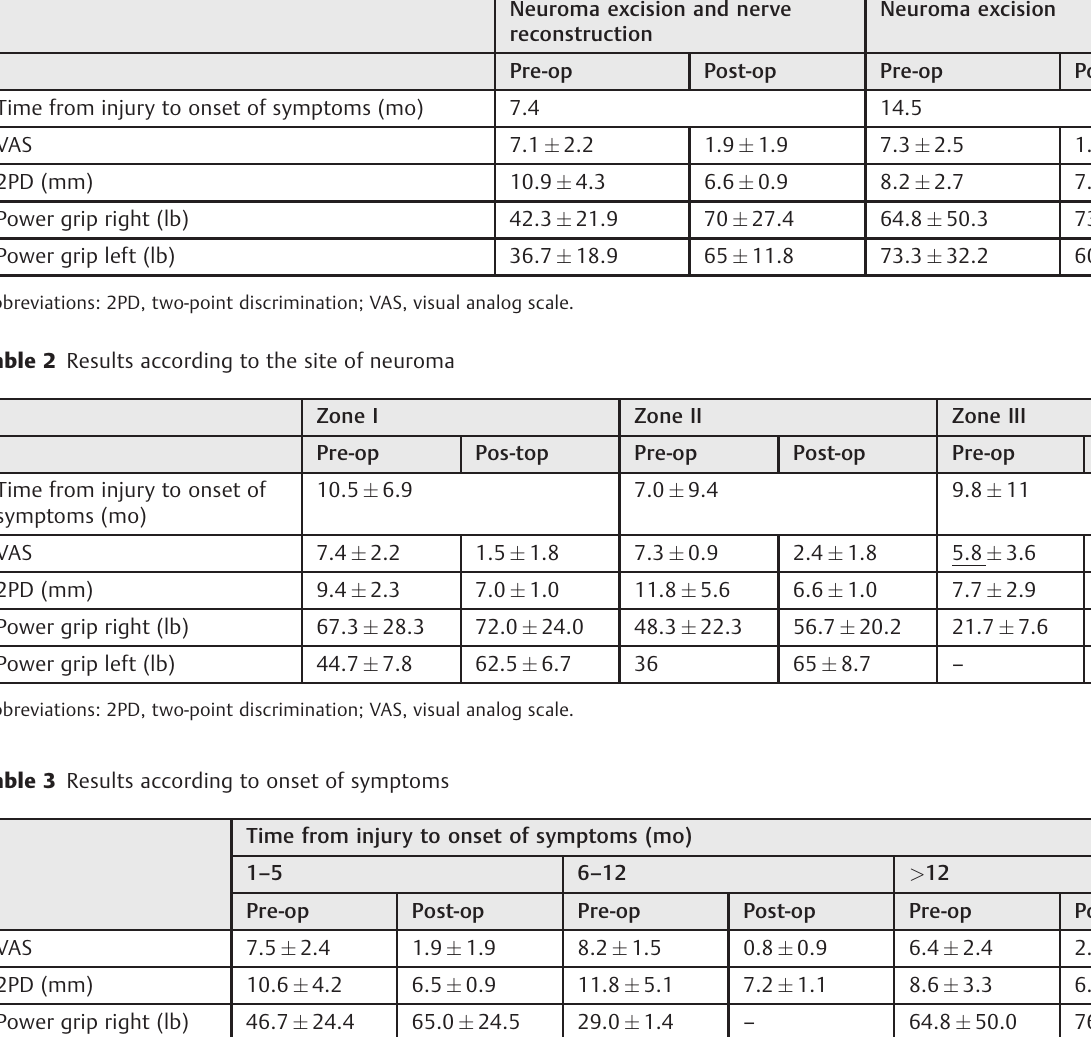
Neuroma excision and nerve reconstruction Pre-op